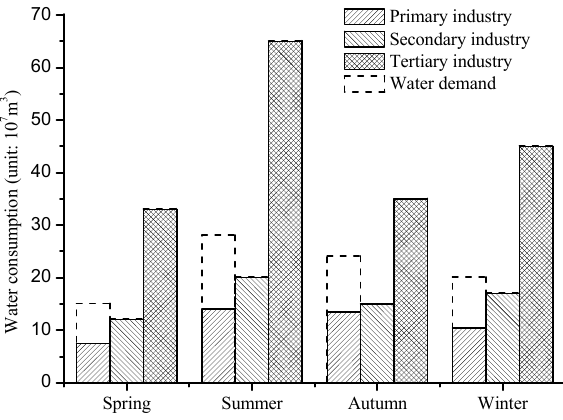
Figure 2. Water consumption of various sectors under violating constraint α = 0.15.